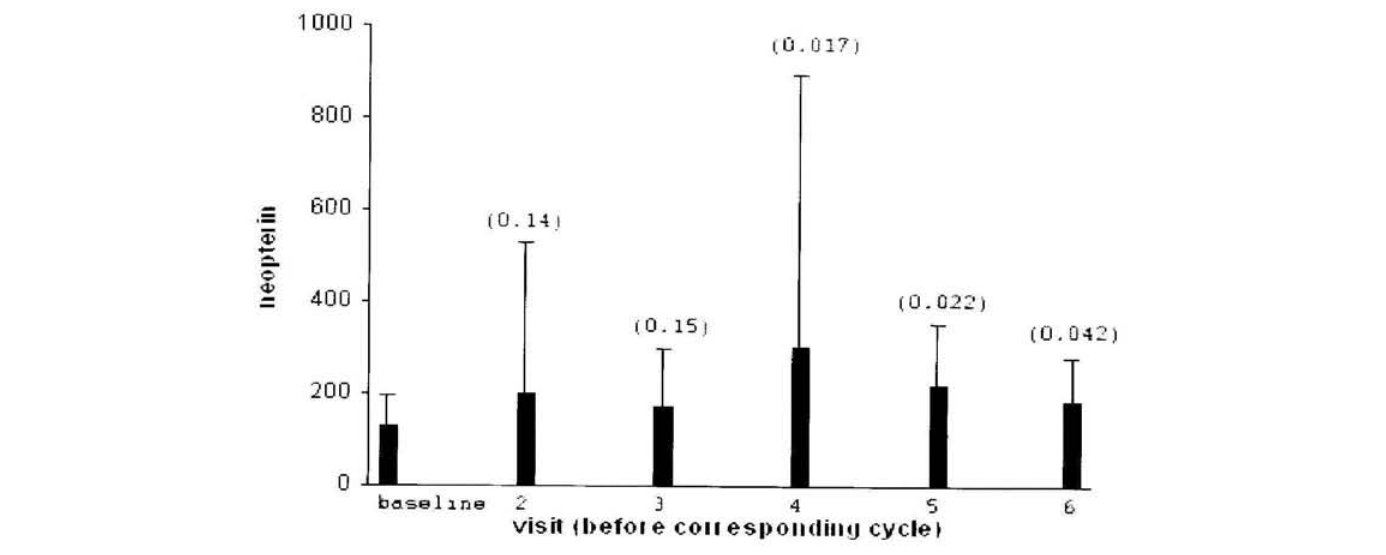
Figure 1: Urinary neopterin concentrations (μιηοΐ/ηιοί creatinine) before and during doxorubicin/paclitaxei com- bination chemotherapy in 51 patients. Urinary neopterin concentrations are shown as μιηοΐ/mol creatinine before cycle 1 (baseline) and before subsequent cycles of chemotherapy; error bars indicate standard deviations, ρ val- ues (shown in brackets) indicate differences compared to baseline